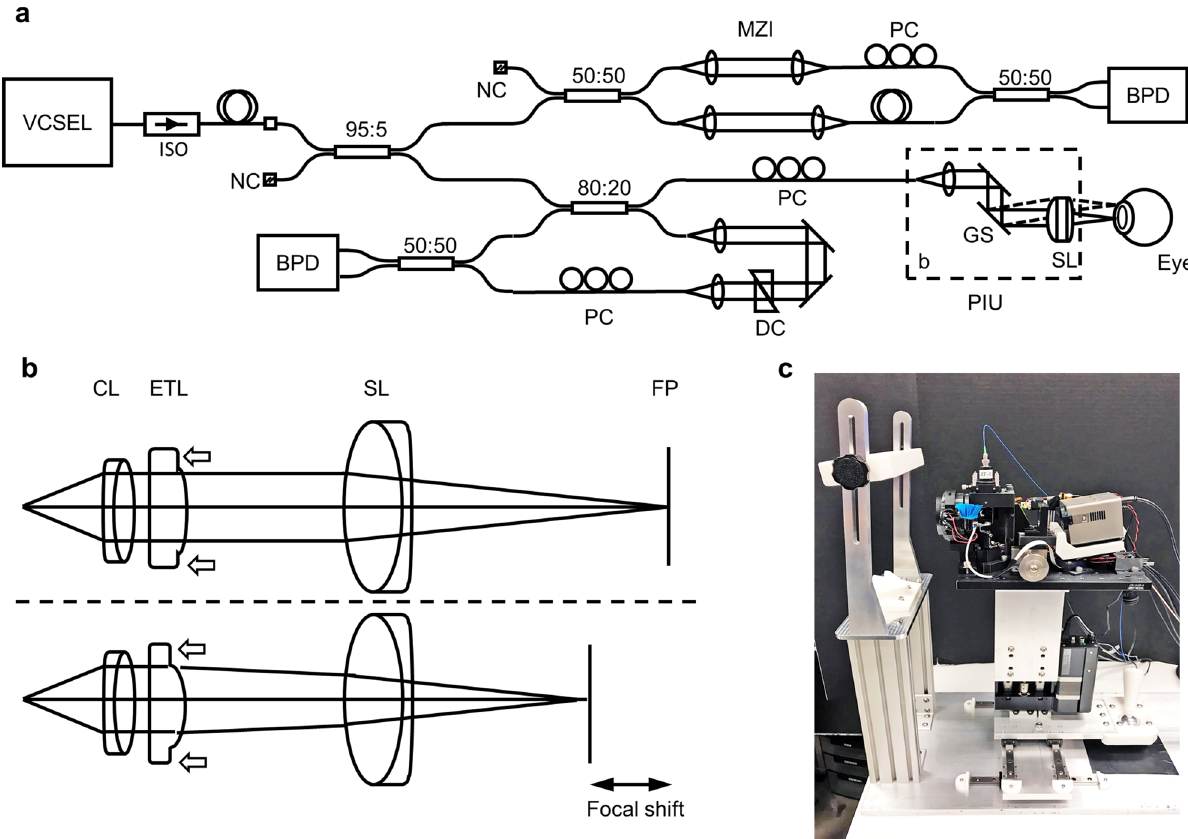
Figure 9. SS-OCT prototype instrument design. ( a ) Schematic of the high speed SS-OCT interferometer. BPD: balanced photo detector; DC: dispersion compensation glass plates; GS: galvanometer scanner; ISO: optical isolator; MZI: Mach–Zehnder interferometer; NC: not connected; PC: polarization controller; PIU: patient interface unit; SL: scan lens. ( b ) Simplified diagram showing dynamic focal plane adjustment using an electrically focus tunable lens. CL: collimating lens; ETL: electrically tunable lens; FP: focal plane. ( c ) Photo of the OCT patient interface unit with cover removed.